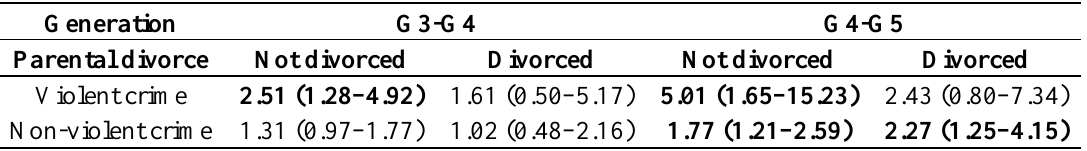
Table 3. GEE models for intergenerational transmission of crime, split by marital status of the